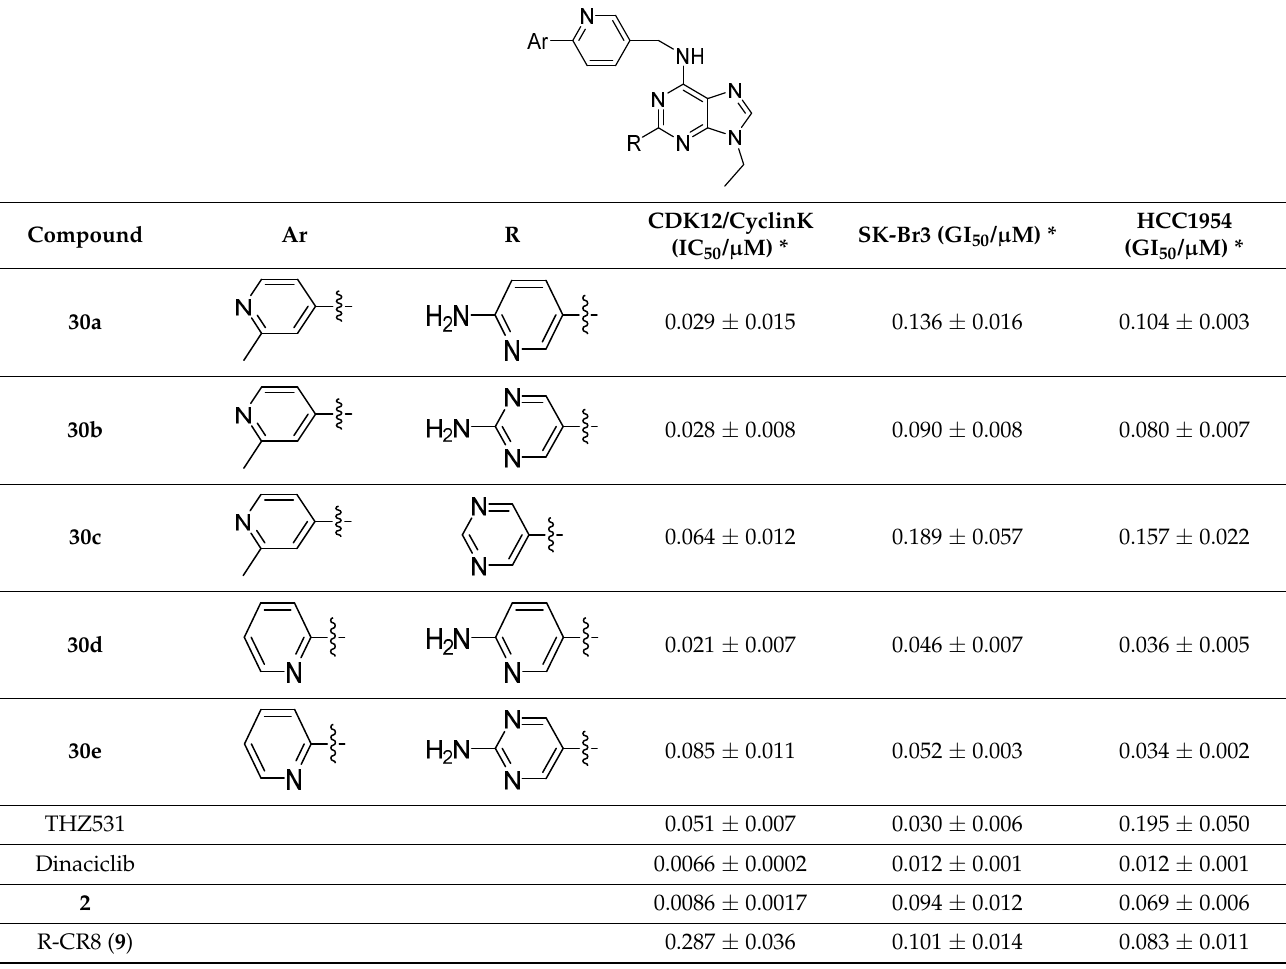
Scheme 4. Synthesis of potent analogues. Reagents and conditions: (a) Pd(PPh 3 ) 4 , K 2 CO 3, 1,4-dioxane, 100 °C, 50–60% yield. (b) NiCl 2 ∙6H 2 O, Boc 2 O, NaBH 4 , MeOH, 0 °C to rt. (c) HCl, rt, 45–55% combined yield for (b) and (c). (d) i PrMgCl, ZnCl 2 , Pd 2 (dba) 3 , XPhos, THF, 65 °C, 65% yield. (e) 14h or 14i , TEA, MeOH, 50 °C, 50–72% yield. (f) boronic acid/ester, Pd(PPh 3 ) 4 , K 2 CO 3, 1,4-dioxane, 100 Table 5. Structure-activity relationship of potent analogues.